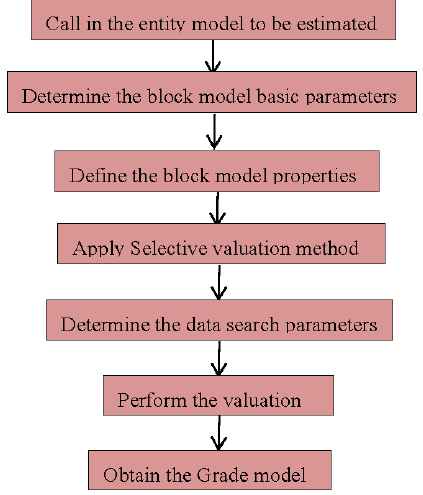
Figure 5: Flow chart of grade model